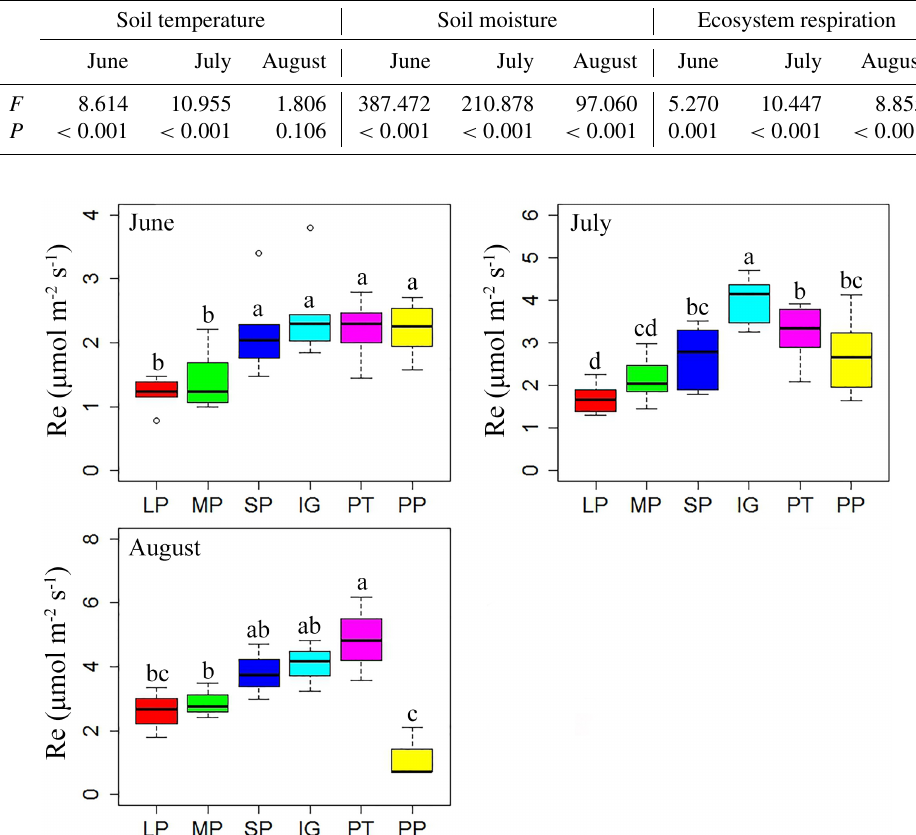
Table 1. ANOVA results of soil temperature, soil moisture and ecosystem respiration in different land surface types.